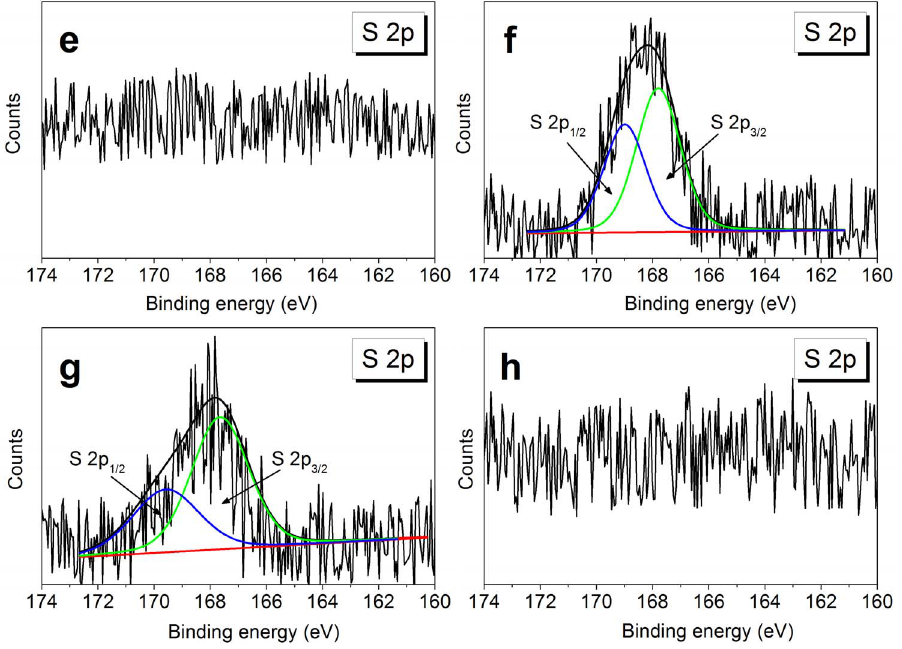
Figure 3. The high-resolution S 2p deconvoluted XPS spectra of (e) WMS, (f) SNC H2SO4,3 , (g) SNC H2SO4,7 , and (h) SNC HCl,7 . doi:10.1371/journal.pone.0086024.g003 PLOS ONE |